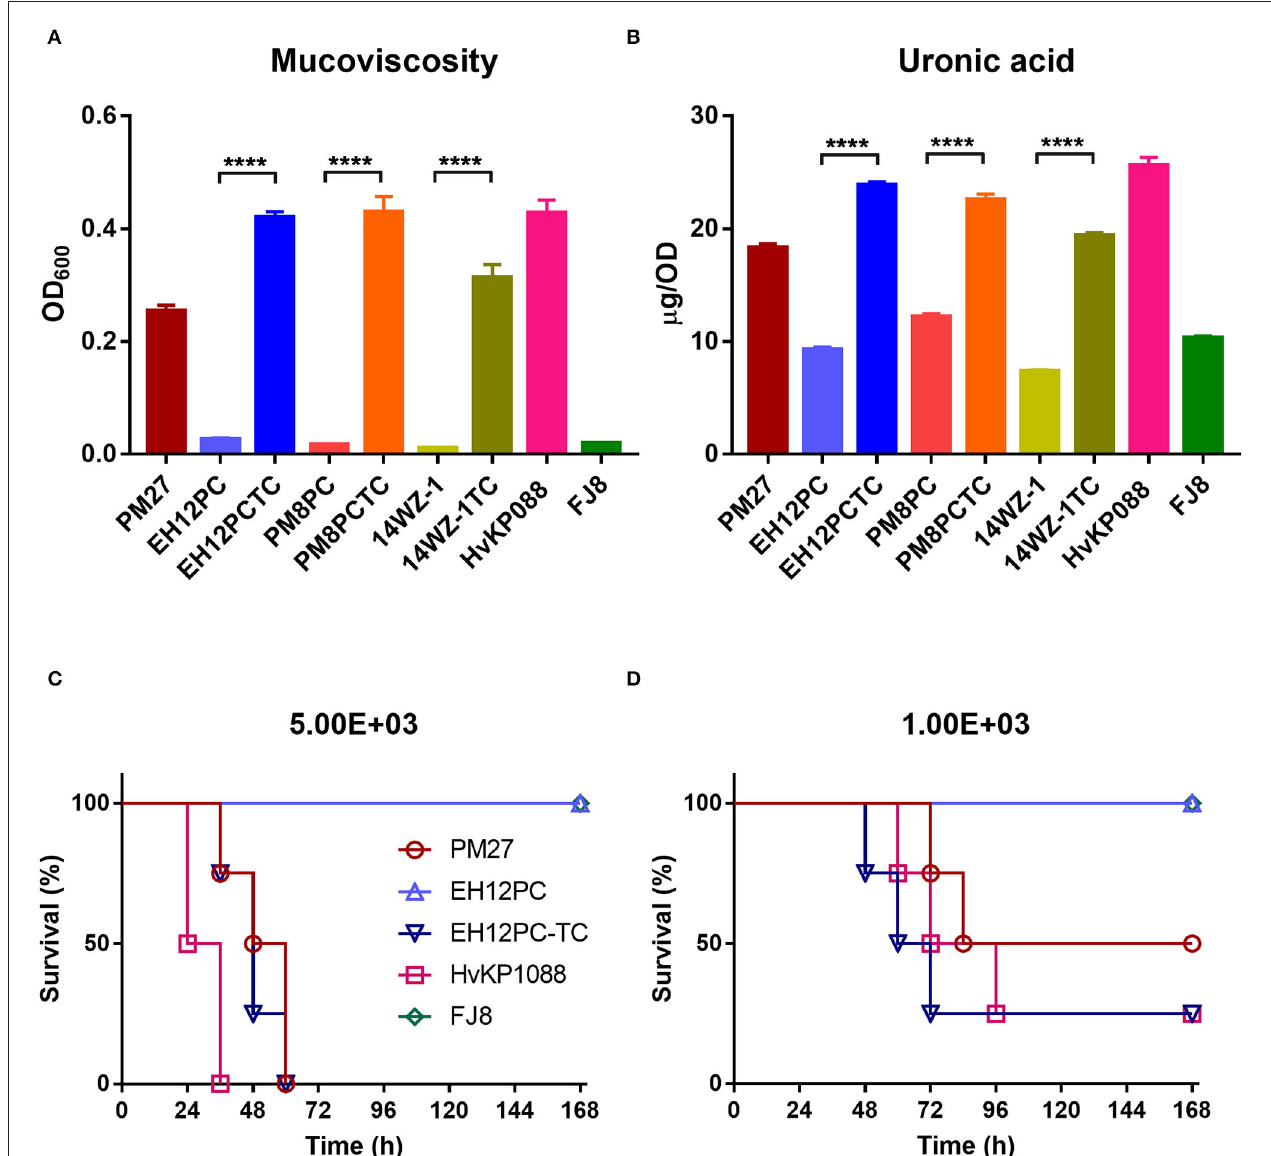
FIGURE 1 | Virulence level of different bacterial strains. (A) Mucoviscosity and (B) uronic acid production for different K. pneumoniae strains. Each data point was repeated three times ( n = 3). Data represent mean ± SEM. Unpaired two-sided Student’s t -test was performed for strains EH12PC-TC vs. EH12PC ( P < 0.0001), PM8PC-TC vs. PM8PC ( P < 0.0001), and 14WZ-1-TC vs. 14WZ-1 ( P < 0.0001). Survival of mice ( n = 8) infected by 5 × 10 3 CFU (C) and 1 × 10 3 CFU (D) of each K. pneumoniae strain at 168 hrs. The test strains included the K. pneumoniae strain PM27, virulence plasmid-cured ST23-KL1 K. pneumoniae strain EH12PC, transconjugant strain EH12PC-TC, HvKP strain HvKP1088 (hypervirulence control), and the classic CRKP strain FJ8 (low-virulence control). The log-rank (Mantel–Cox) test was performed for curves of strains EH12PC and EH12PC-TC. A significant difference ( P = 0.0069 and 0.0401 at an inoculum of 5 × 10 3 and 1 × 10 3 CFU, respectively) was observed between curves.